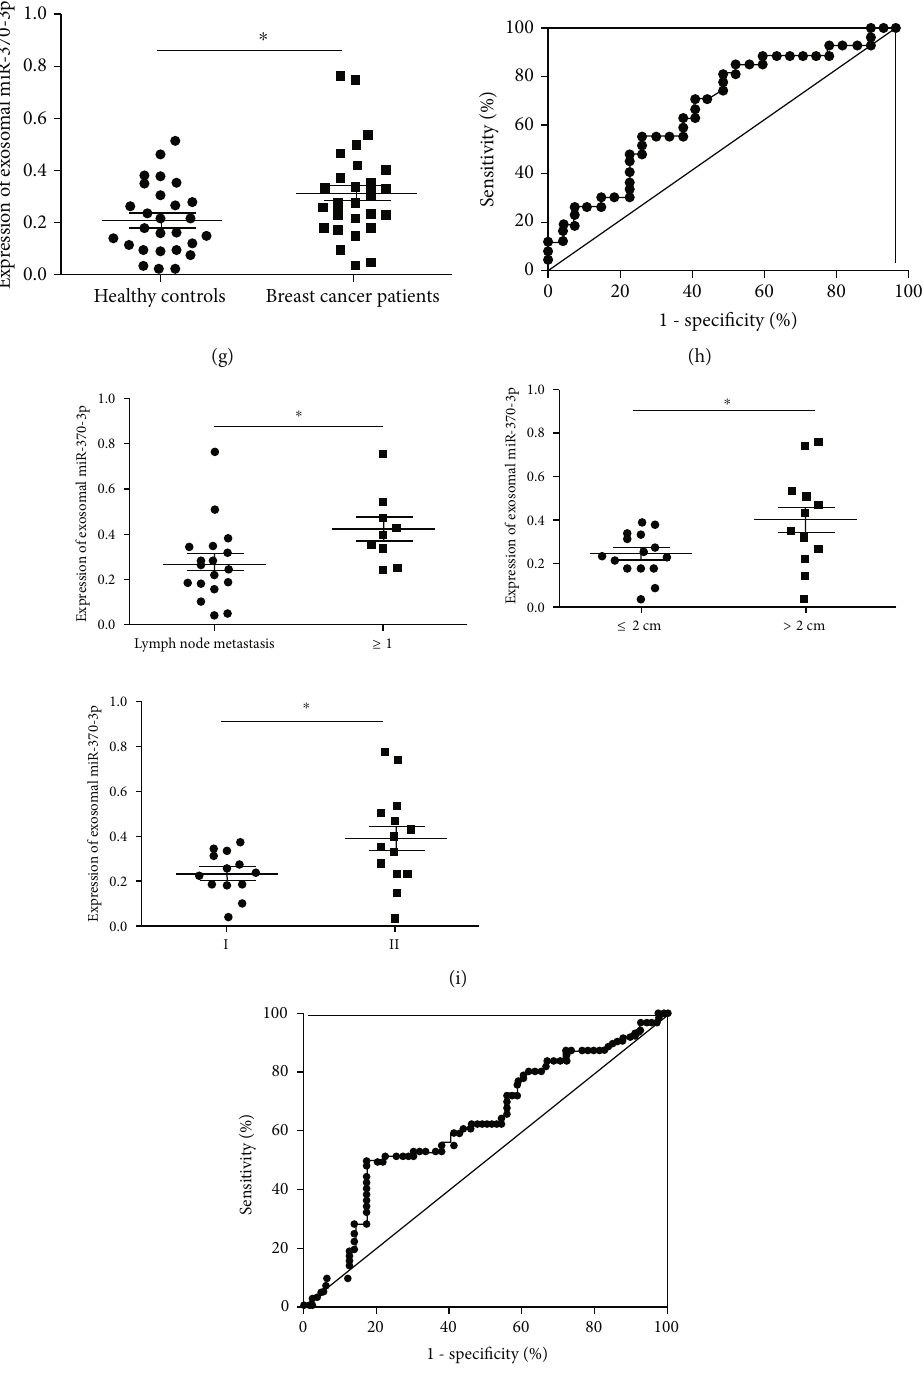
Figure 6: The detection of miR-370-3p expression in breast tissues, serum, and serum exosomes. (a) The levels of miR-370-3p in adjacent normal tissues and breast cancer tissues. ∗∗∗ P < 0 : 001 . (b) The diagnostic values of miR-370-3p ROC curves in breast cancer tissues. (c) The correlation between the levels of miR-370-3p and clinicopathological parameters (lymph node metastasis) in breast cancer tissues. ∗ P < 0 : 05 . (d) The expression of miR-370-3p in the serum of 28 healthy volunteers and that of 28 patients with breast cancer. ∗ P < 0 : 05 . (e) The diagnostic values of miR-370-3p ROC curves in breast cancer serum. (f) The correlation between the levels of miR-370-3p and clinicopathological parameters (lymph node metastasis and TNM stage) in breast cancer serum. (g) The levels of miR-370-3p in the exosomes of serum in 28 healthy volunteers and that of 28 patients with breast cancer. ∗ P < 0 : 05 . (h) The diagnostic values of miR-370-3p ROC curves in breast cancer serum exosomes. (i) The correlation between the levels of miR-370-3p and clinicopathological parameters (lymph node metastasis, tumor diameter, and TNM stage) in serum exosomes of breast cancer. ∗ P < 0 : 05 . (j) The ROC curve of serum